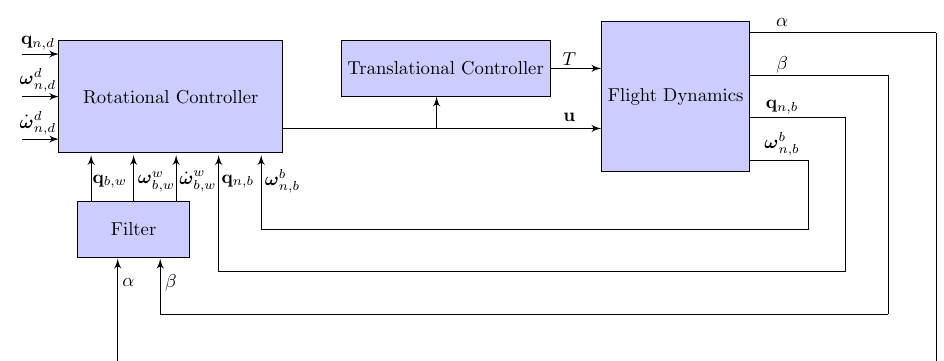
Figure 3: Resulting control structure.